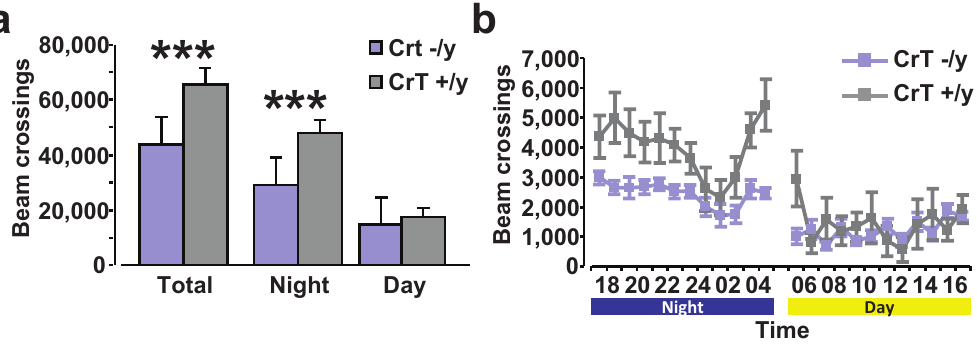
Figure 7. Locomotor activity in CrT –/y mutant mice and the wild-type parental strain. ( a ) Total horizontal distance travelled throughout 24h (left), and over the dark (middle) or light phase (right). CrT –/y mice had a significant decrease in motor activity in comparison to control animals during the whole period of testing (CrT –/y : 43,594.22 ± 2,639.39 beam crossings, CrT +/y : 65,587.63 ± 5,831.19 beam crossings) and the night phase (CrT –/y : 29,109.67 ± 1,695.35 beam crossings, CrT +/y : 48,094.13 ± 4,843.56 beam crossings; Two-Way ANOVA, post hoc Holm-Sidak method, p < 0.001 for both comparisons), while the motor behavior of the two groups was similar in the day-time (CrT –/y : 14,484.56 ± 1,458.08 beam crossings, CrT +/y : 17,493.50 ± 2,957.57 beam crossings; p = 0.535). ( b ) Time course of horizontal activity of CrT –/y (blue) and CrT +/y (grey) animals during 24h. Data are plotted as total number of beam crossings ± SEM in each time block of 60 min. Dark and light phases are indicated. *, statistical significance. Error bars,